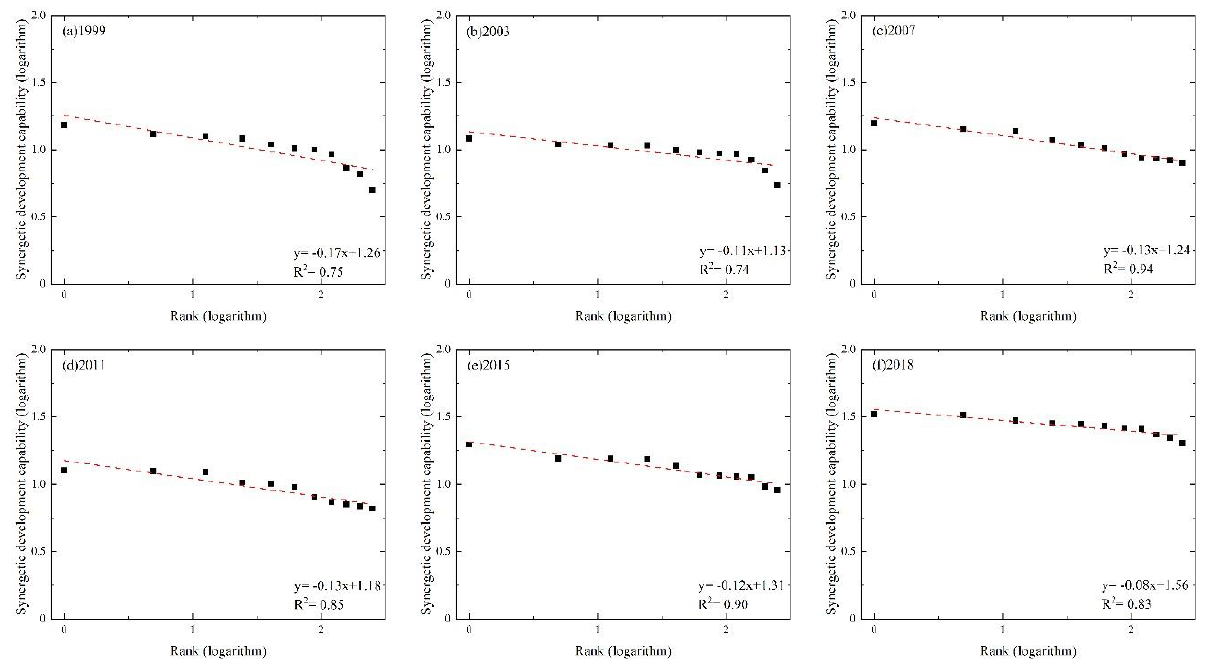
Figure 5. The rank-size rule of the coupling system in 11 provinces.